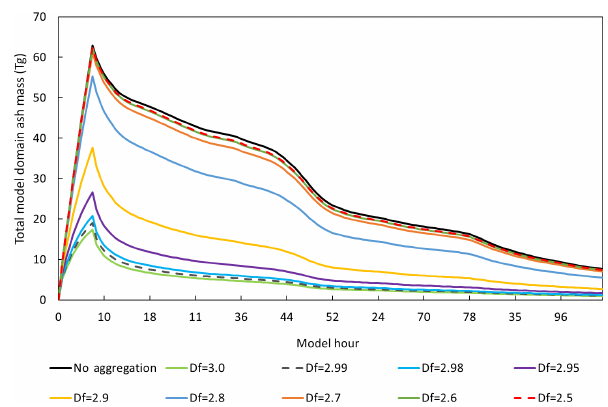
Figure 3. Change in total domain ash mass (teragrams) for a hy- pothetical eruption on 5 May, beginning at 00:00Z and ending at 09:00Z, for a range of fractal dimensions, D f = { 3.0, 2.99, 2.98, 2.95, 2.9, 2.8, 2.7, 2.6, 2.5 } . Constant eruption rate = 4 × 10 6 kgs − 1 .